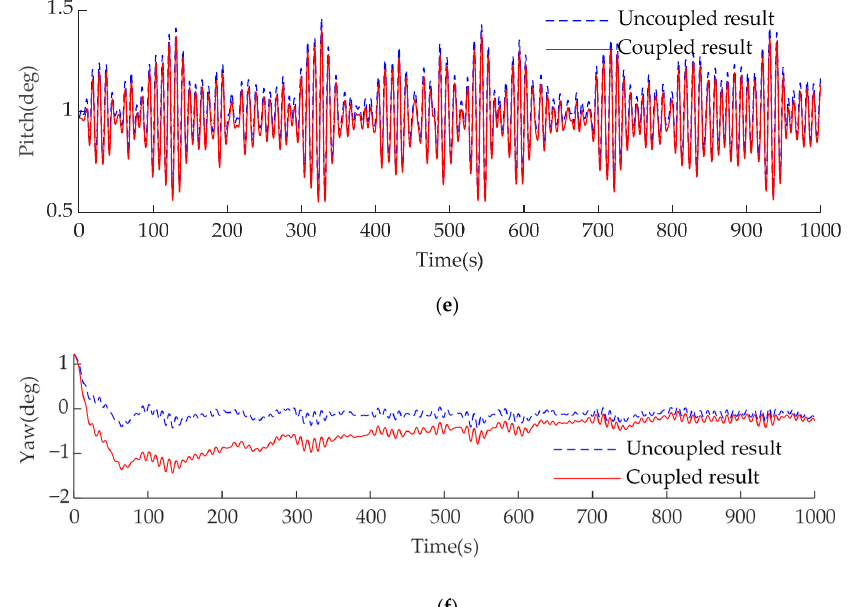
Figure 13. Time histories for the vessel’s six degrees of freedom of motion for uncoupled and coupled results: ( a ) Surge, ( b ) Sway, ( c ) Heave, ( d ) Roll, ( e ) Pitch, and ( f ) Yaw.